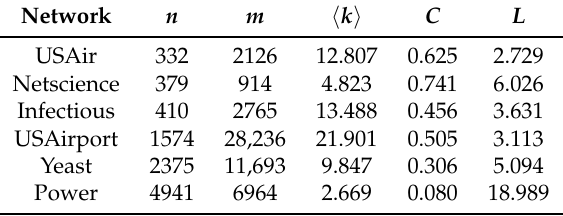
Table 1. Basic statistical properties of the six real networks, including network size ( n ), edge